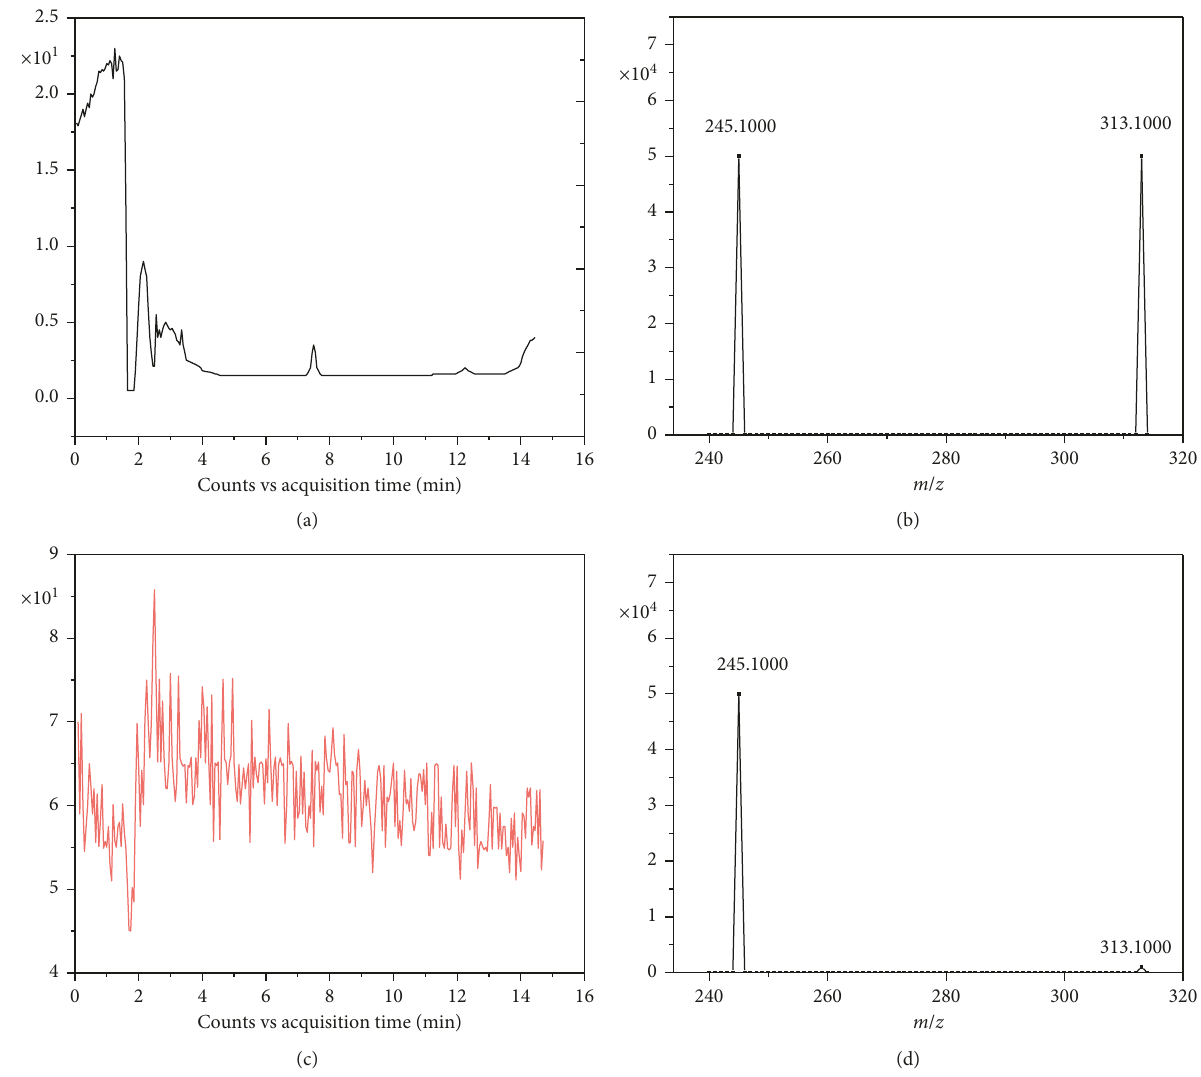
Figure 3: (a) Chromatogram of AFB1-contaminated sample before treatment, (b) mass spectrum of selected ion (molecular base ion peak) of AFB1 before treatment, (c) chromatogram of AFB1-contaminated sample after treatment with garlic extract for 24h mass spectrum of selected ion (molecular base ion peak) of AFB1 after